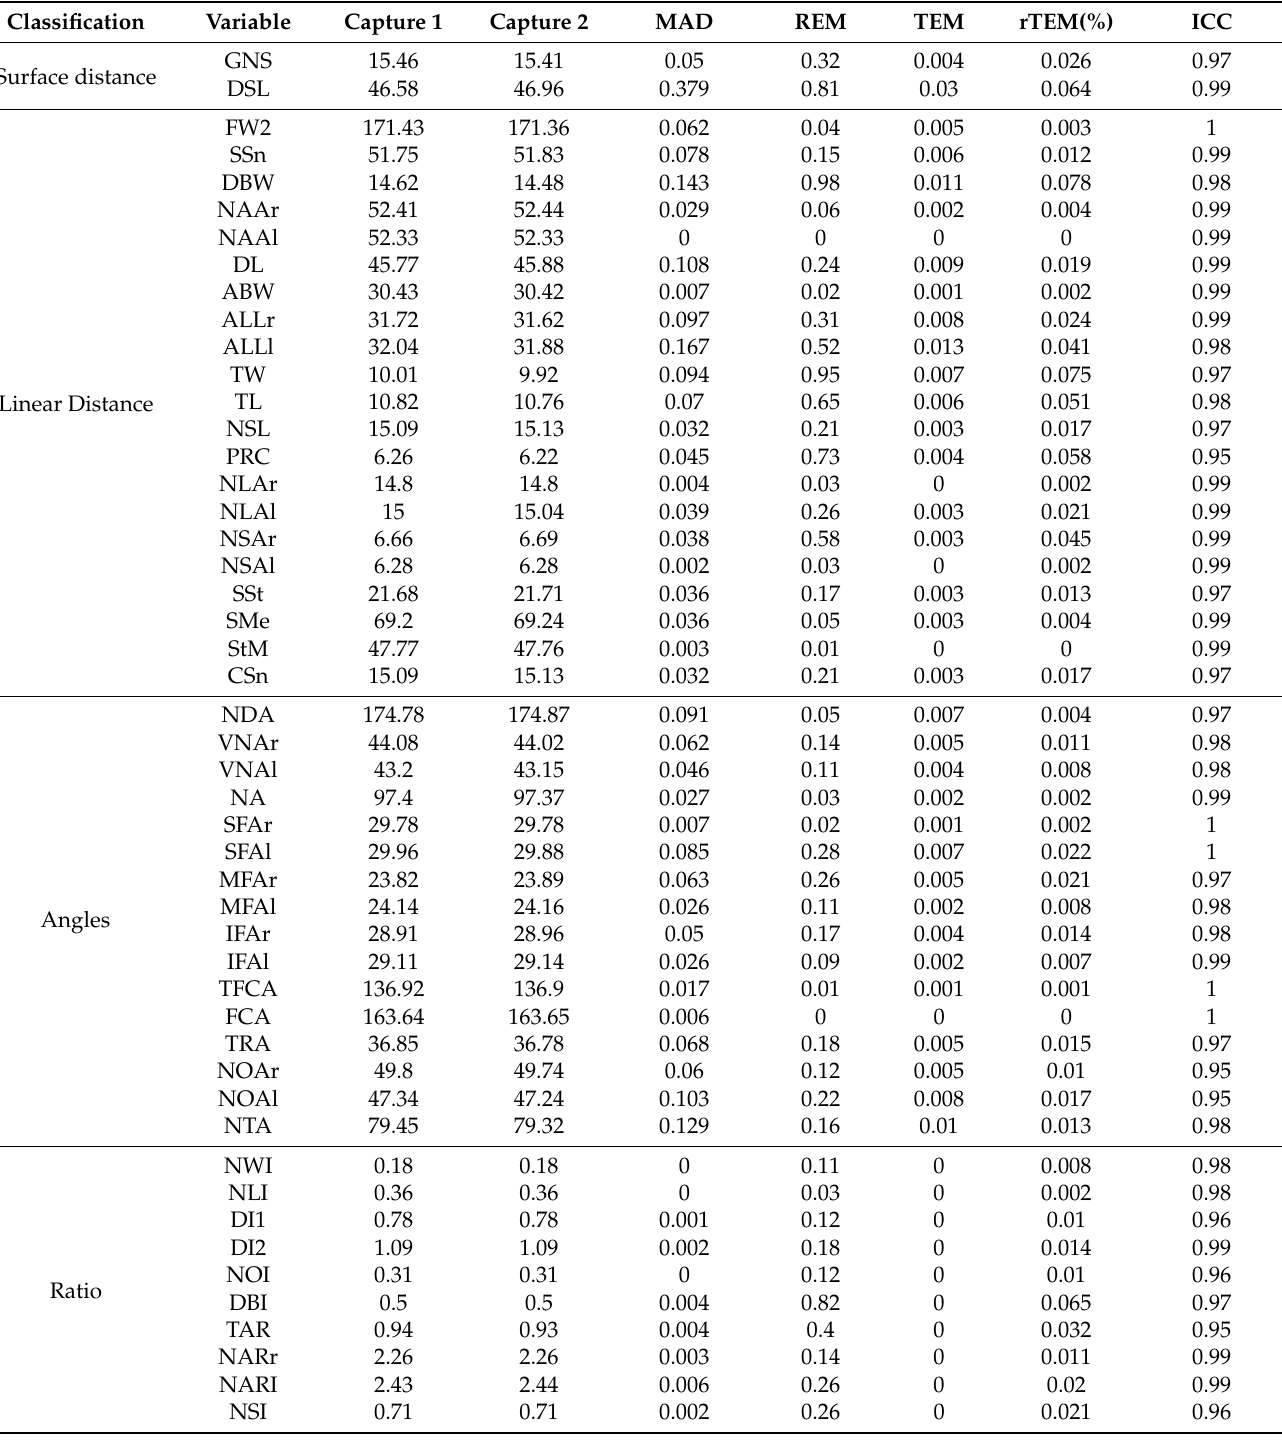
Table 8. The intra-method reliability of novel